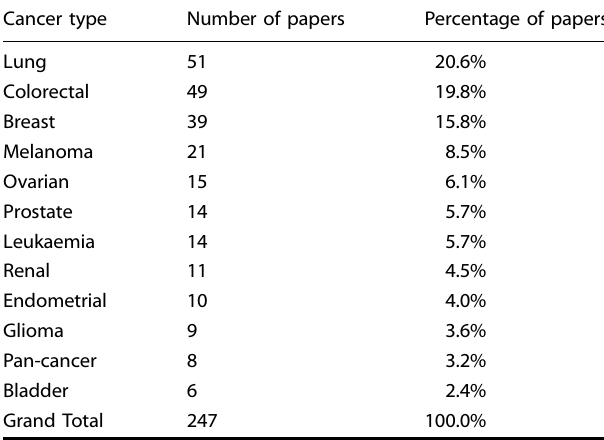
Table 1. Number of studies reviewed by cancer